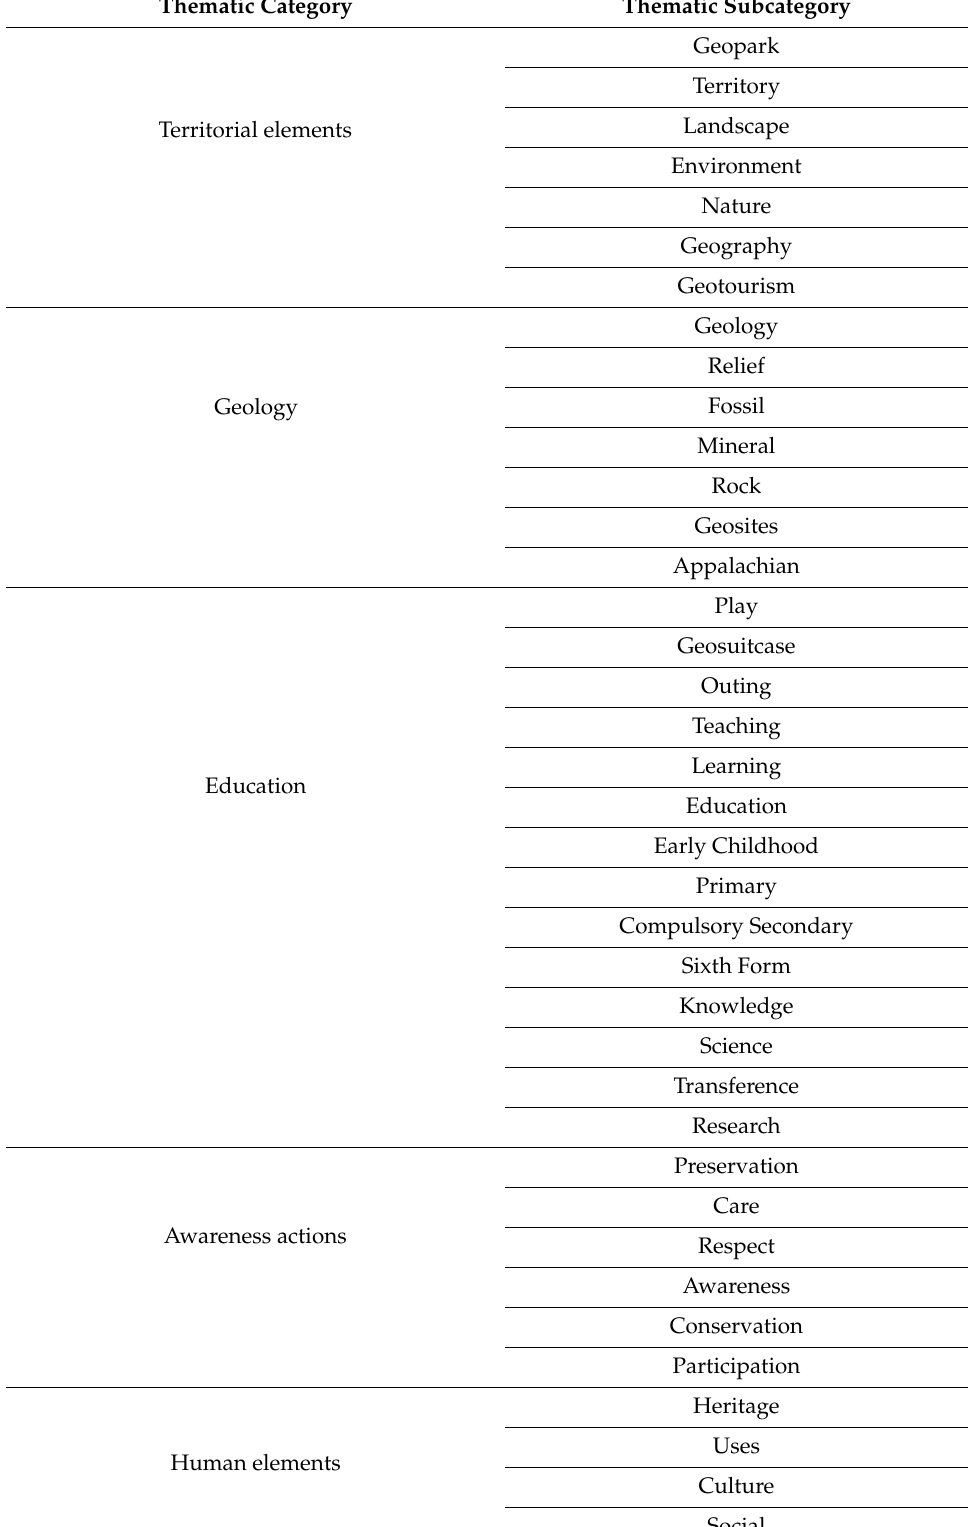
Table 2. Categories and keyword. Source: author’s own